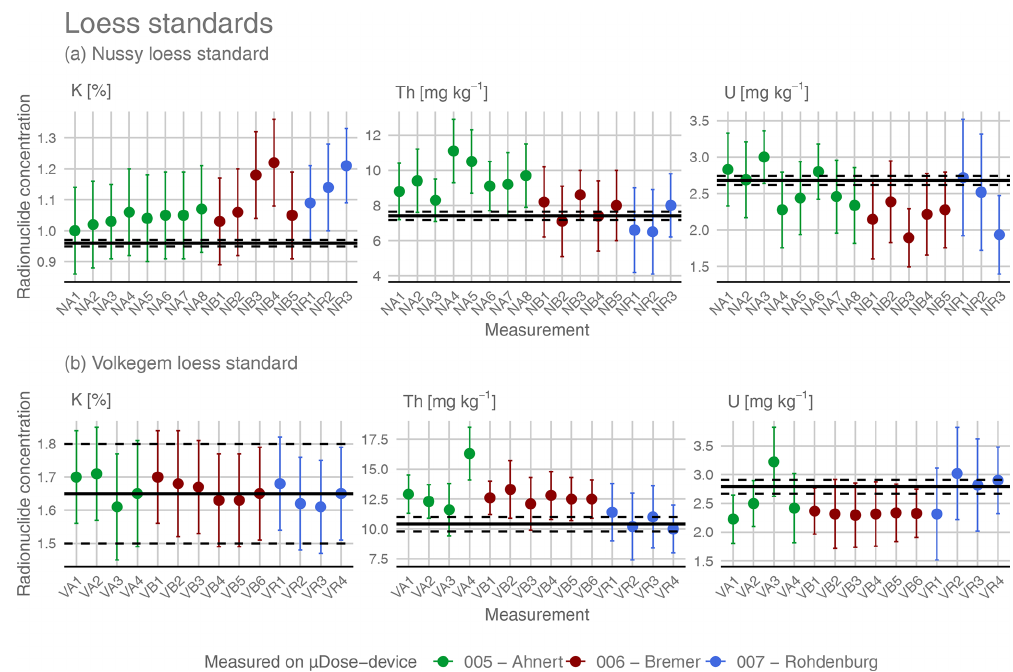
Figure 3. Results from repeated µ Dose measurements for the loess standards Nussy (a) and Volkegem (b) . The different colours of the symbols represent three different measurement devices (see legend). All plots show radionuclide concentrations either in milligrams per kilogram (mgkg − 1 ) (U and Th) or in percent (K). Please note that the bold reference lines indicate radionuclide contents originally published for the Nussy loess standard by Preusser and Kasper (2001) and for the Volkegem loess standard by De Corte et al. (2007). Dashed lines characterize the corresponding 95% CI. Error bars indicate measurement uncertainties on the 2 σ level.